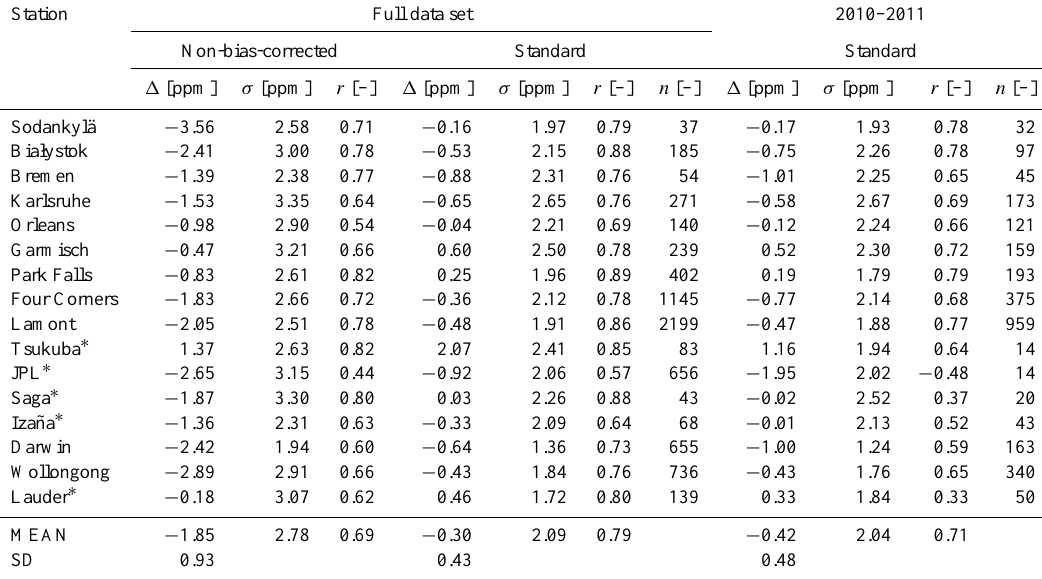
Table 5. Results of the comparison between GOSAT BESD and TCCON XCO 2 for individual (single measurement) satellite data. Shown are the results for non-bias corrected and standard (bias-corrected) GOSAT BESD of the full time series (January 2010–December 2013, see Fig. S1 for the time series of the standard GOSAT BESD) of the data set and for a 2010–2011 sub-set of the standard GOSAT BESD data product. (cid:49) is the mean difference between GOSAT BESD and TCCON XCO 2 , σ is the standard deviation of the difference, r is the correlation coefficient between the time series and n the number of collocations. Stations marked with ∗ have less than 30 collocations in one of the comparisons of GOSAT BESD or SCIAMACHY BESD XCO 2 with TCCON XCO 2 . Therefore, these comparisons should be interpreted with care. The mean offset (mean of the mean differences), the estimated single measurement precision (mean of the standard deviation of the difference), the mean correlation coefficient and the station-to-station bias (standard deviation of the mean differences) are calculated without these stations.